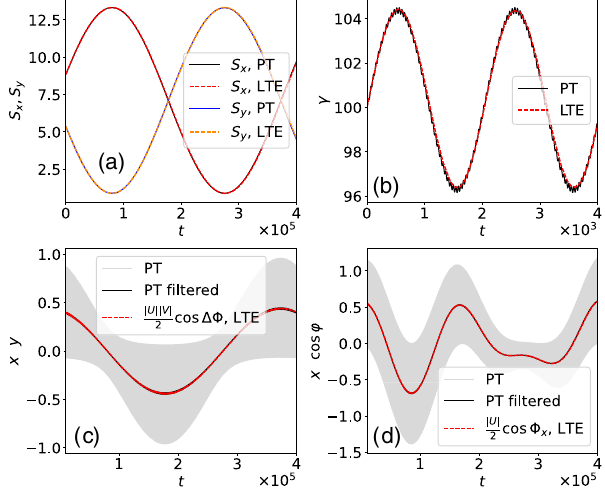
FIG. 1. The numerical comparison of the LTEs and the original equations solved by PTracker in the betatron phase shift dominant regime. (a) S x and S y change with the period π = Ω ¼ 3 . 89 × 10 5 according to Eq. (37), but S x þ S y is a constant. (b) γ has oscillation frequencies of 2 ω β ≈ 0 . 14 due to the BO and ω h ζ i ≈ 3 . 11 × 10 − 3 due to the drift oscillation of h ζ i . (c) The gray curve shows xy obtained from PT, and the black curve shows its low- pass filtered result, which is compared with the LTE solution according to Eq. (39). (d) The gray curve shows x · cos φ obtained from PT, and the black curve shows its low-pass filtered result, which is compared with the LTE solution according to Eq.